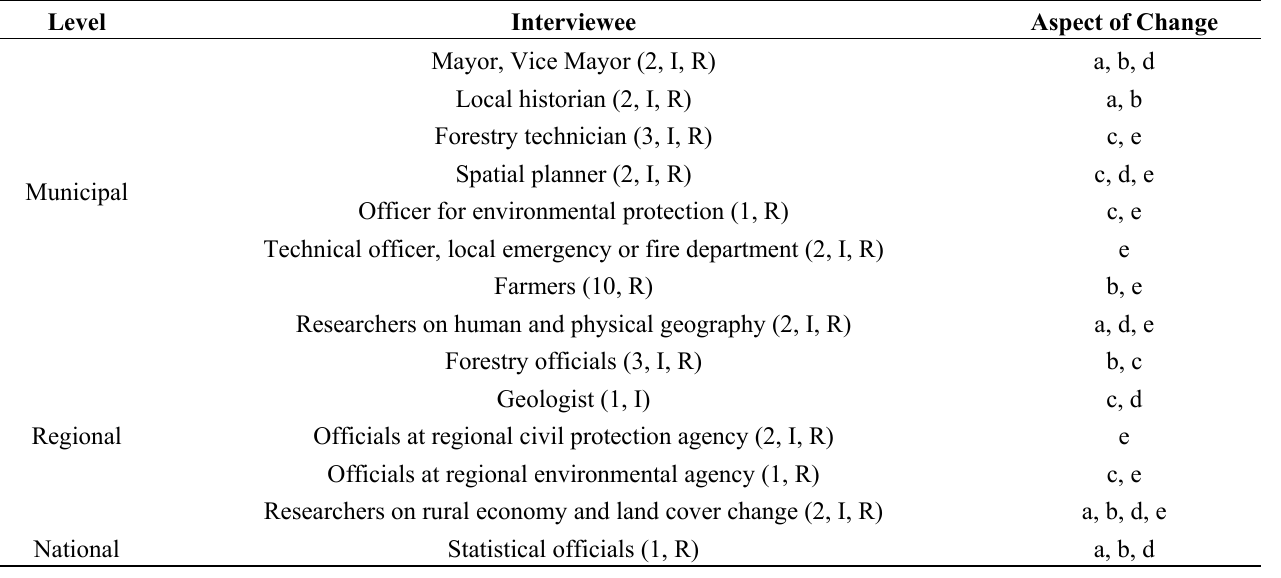
Table 1. List of